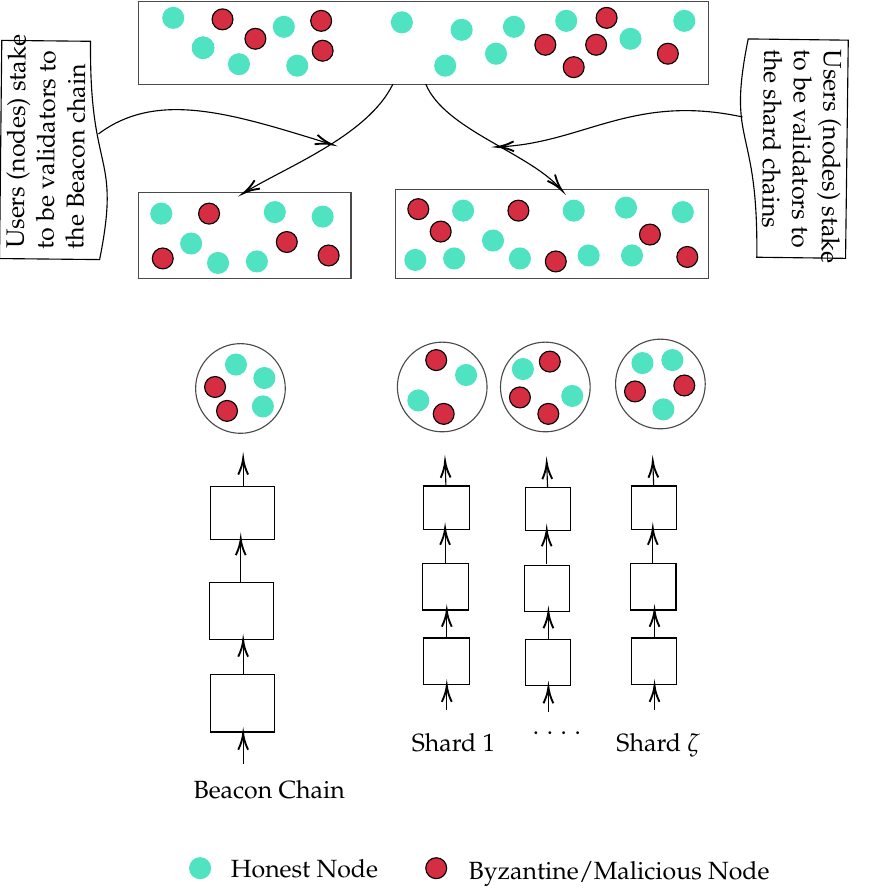
Figure 1. A sharding-based PoS and pBFT Blockchain